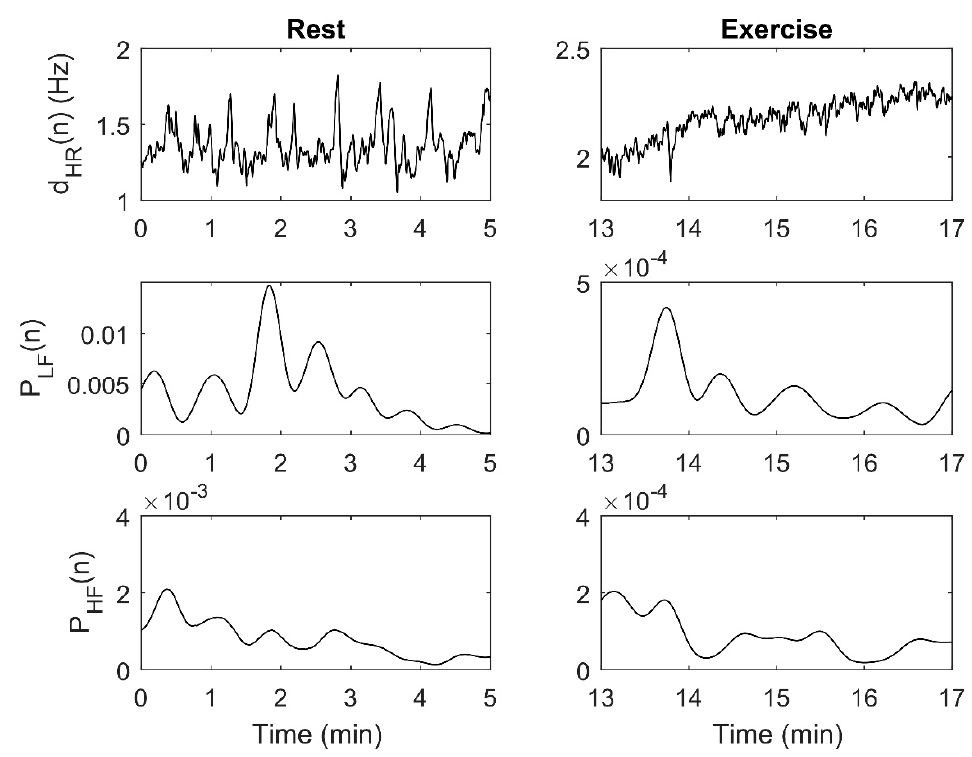
Figure 2. Example of d HR ( n ) , P LF (n) and P HF (n) obtained from RR E for one subject: Resting segment ( left ) and cycling segment ( right ). Note that the axes have different scales. d HR ( n ) = instantaneous HR signal; P LF (n) = Instantaneous low-frequency power; P HF (n) = Instantaneous high-frequency power; RR E = RR intervals series from the ECG.